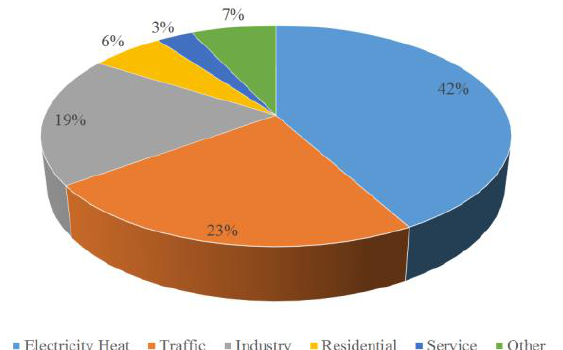
Figure 1. Causality diagram.